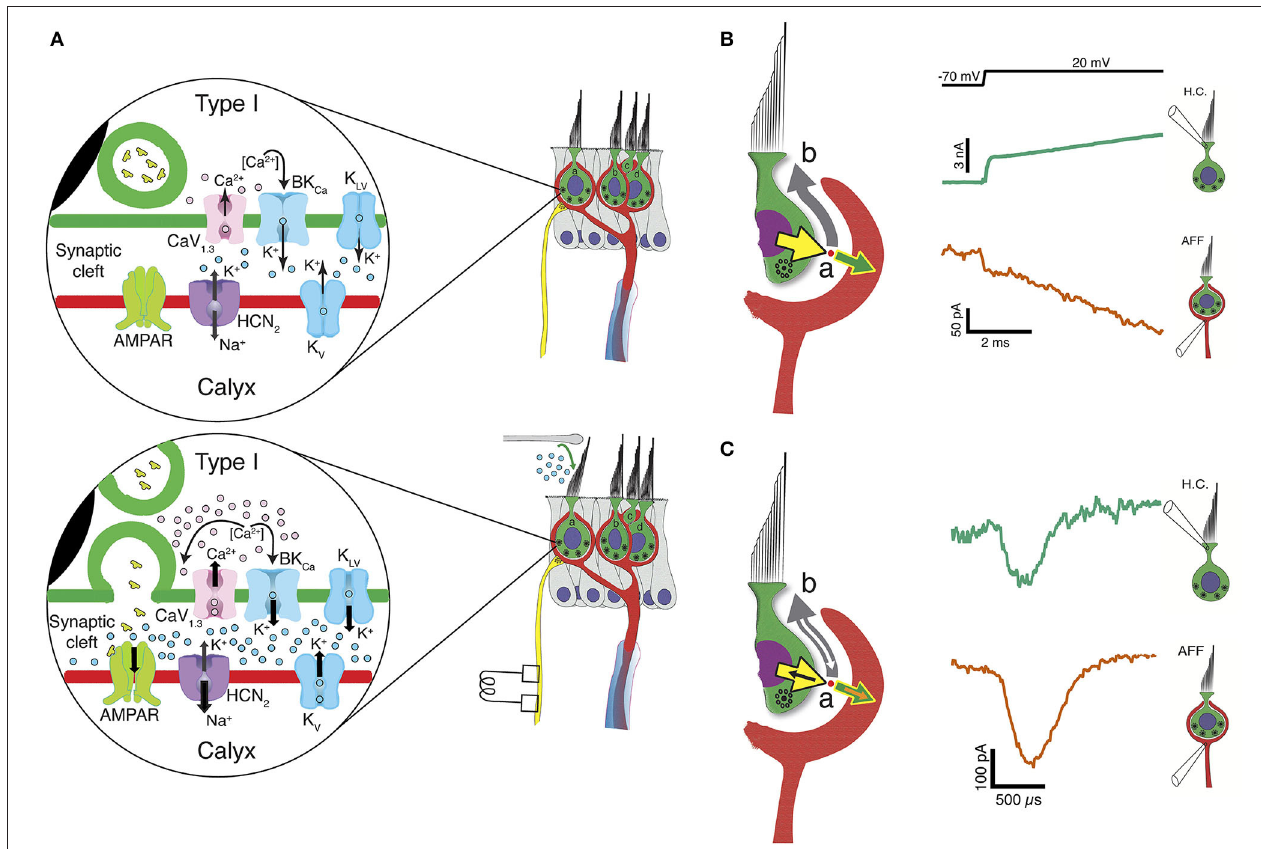
FIGURE 2 | Three forms of synaptic transmission between a Type I HC and calyx afferent. (A) In the absence of mechanical stimulation (upper panel), basolateral potassium currents activated at hyperpolarized potentials elevate the [K + ] cleft to concentrations near 8mM, twice that found in perilymph. This results in a shift in E K and depolarization of the HC to a resting potential between − 60 and − 50mV, where Ca 1,3 channels are activated. At rest there is occasional vesicle fusion and the production of a background rate of afferent discharge. Upon mechanical stimulation (lower panel), the inward transduction current flows into the HC and out the basolateral conductances into the cleft as a potassium current. The further increase in [K + ] cleft is a low-pass integral of the transduction current and further depolarizes E K for conductances in the HC and afferent membranes facing the cleft. The HC depolarization gates Ca 2 + influx, resulting in fusion of synaptic vesicles and quantal transmission of glutamate to AMPARs on the calyx inner leaflet. The slow accumulation of potassium thereby facilitates quantal transmission near the resting potential, and for maintained depolarizations toward 0mV, elevates [K + ] cleft to greater than 28mM within 25ms. It is likely that the irregularities of vesicle fusion and large quanta that initiate an AP are driven by neighboring Ca-channel noise ( 108), and as a consequence the degree of regularity of afferent discharge would be determined by the degree to which the post-synaptic afferent conductances have intrinsic memory and oscillatory behavior similar to those found in HCs of the turtle auditory papilla ( 90, 109). (B) Large conductances in the HC and calyx near the resting potential also create an open resistive pathway between the two that permits a fraction of the transduction current to be communicated across the cleft and into the calyx without synaptic delay. Outward current from the HC (yellow arrow) divides at point (a) into a large component (gray arrow) going along the cleft into the bath at point (b), and a smaller current flowing into the calyx (green arrow). The measured current for the HC (bluish-green current trace) and calyx (vermillion trace) show transmission within 10 µ s. (C) Resistive coupling can also be demonstrated during large HC depolarizations that depolarize the calyx to potentials sufficient to generate an AP that travels into the calyx. Currents due to the invasion of an AP will sum with the primary currents illustrated in (B) . With an AP, an additional inward current (orange arrow) flows into the calyx, with an amplitude equal to the sum of the corresponding currents flowing into the HC (black arrow) and down the cleft (white arrow). The coupling between the calyx retrograde AP current (vermillion) and the induced HC current (bluish-green) is 12 µ s [modified from